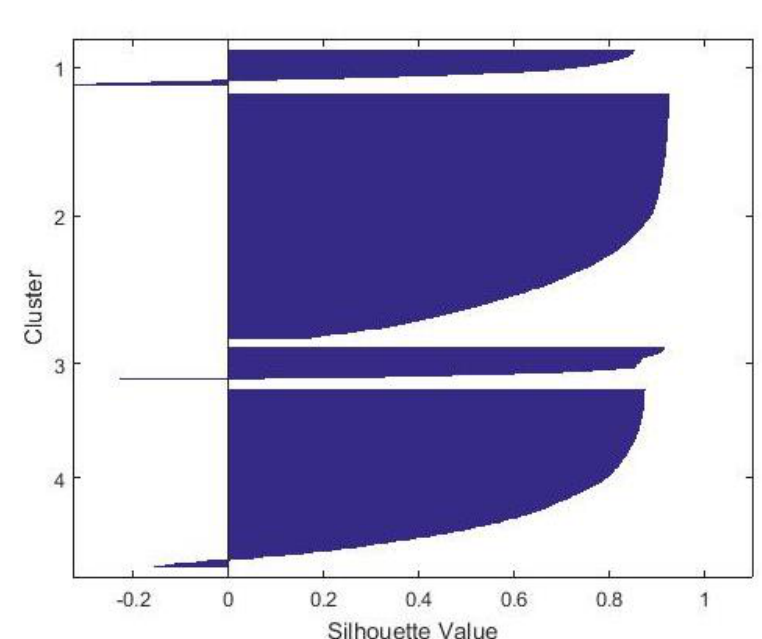
Figure 11. Silhouette diagram for elevation clusters when k = 4.